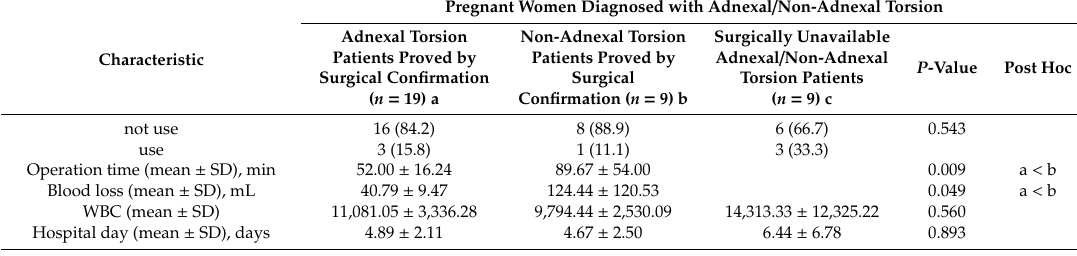
Figure 3. A 34-year-old pregnant woman (35.2 weeks) with acute salpinx torsion with hemorrhagic infarction in the salpingectomy group. ( A ), ( B ) Transaxial and sagittal T2-weighted fast spin-echo MR images show slightly swollen ovary (not seen in this figure) and hyperintense fallopian tube or fimbriae (arrow). ( C ) Transaxial diffusion-weighted MR image shows heterogenous slightly hyperintense swollen fallopian tube (arrow). ( D ) Apparent diffuse coefficient (ADC) map shows diffusion restriction of fallopian tube or fimbriae (arrow). ADC value in a circle indicating the region of interest (ROI) placed in fallopian tube or fimbriae was 0.96 ± 0.13 × 10 −3 mm 2 /s. ( E ), ( F ) Intraoperative photograph reveals a necrotic fallopian tube or fimbriae (arrowhead) under laparotomy. (Color version of the figure). This study revealed unilocular ovarian cysts in 36.8% (7/19), multilocular ovarian cysts in 31.6% (6/19), and near normal-appearing ovaries in 31.6% (6/19) on preoperative MRI. The pathology results revealed a corpus luteal ovarian cyst in 63.2% (12/19) and underlying adnexal pathology in 46.8% (7/19). In the nonadnexal torsion group, radical treatment of one case (adnexectomy) was decided due to ovarian malignancy. The final pathology-based diagnoses were corpus luteum cyst ( n = 4), mature